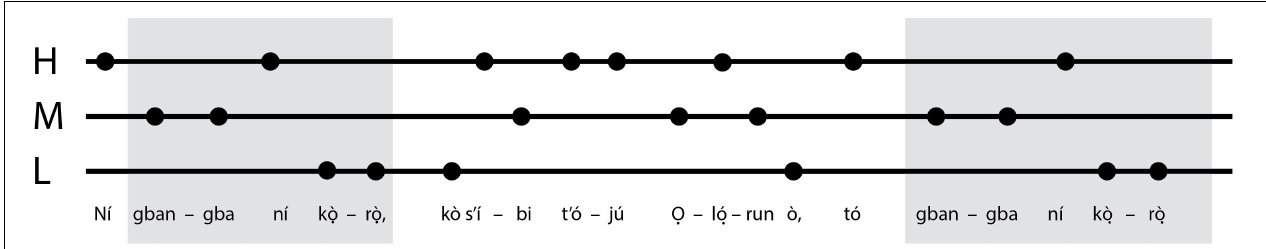
FIGURE 1 | Transcription of a Yorùbá proverb played on the dùndún (stimulus 6S in our corpus). The dots placed on the three horizontal lines represent a schematic depiction of the pitch changes (high, medium, or low) as the phrase written underneath would be spoken in the Yorùbá language. The phrase translates to “Public or private, there is no place the God cannot see, public or private.” Though the phrase would typically be spoken without the repetition at the end, when played on the dùndún the proverb is elaborated by repetition of the first phrase (gray shaded areas), as repetition is often a means to provide context and remove ambiguity in meaning (Stern, 1957; Arewa and Adekola,